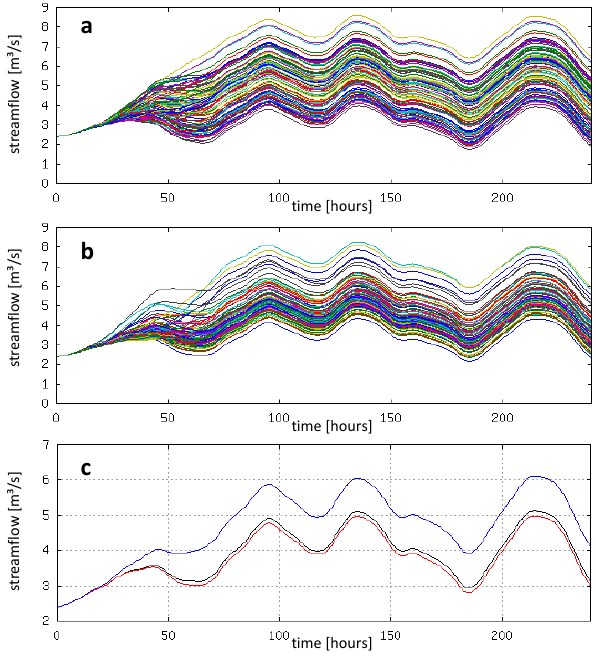
Fig. 6. The streamflow at Pforzheim starting on 5 May 1997 with the CONTROL streamflow value: (a) simulated for all (back- ground) ensemble members of initial soil moisture with TERRA- ML and river routing scheme, (b) ensemble of analysis members re- sulting from EnKF, and (c) streamflow from the CONTROL (blue) simulation, simulated with the initial mean soil moisture of the background ensemble (red) and simulated with the initial mean soil moisture analysis (black).